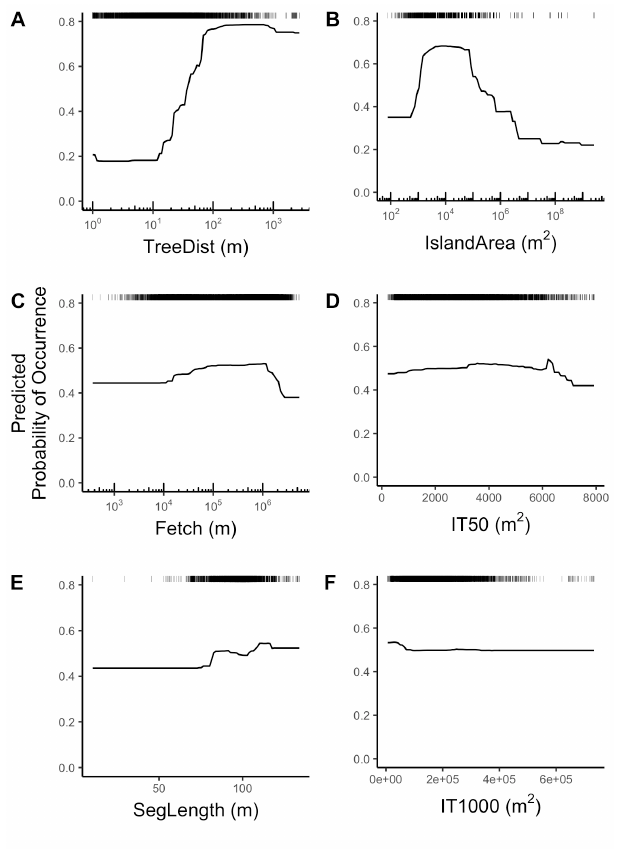
Fig. 2 . Partial dependence plots for continuous predictors retained in final model. Partial dependence plots show the effect of a given predictor on the response, with all other predictors held at their mean. Rug plots at the top show the distribution of surveyed segments across that predictor.